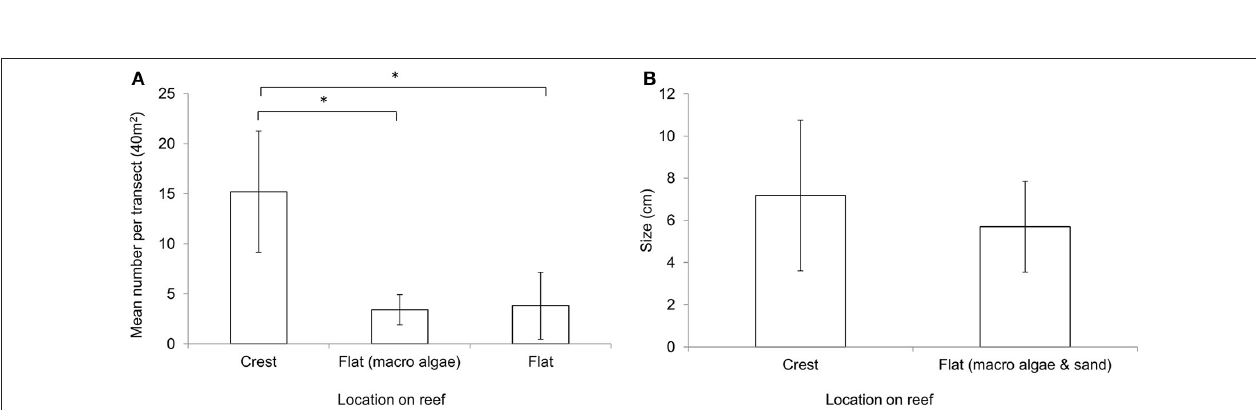
FIGURE 3 | Mean ( ± SD) photosynthetic efficiency (F V /F M ) for each of the four treatment groups over the 4 day period for (A) 0700, Low PAR and (B) 1100, high PAR. Flat and crest control groups: individuals measured without moving from respective locations on reef; handling group: individuals moved from reef crest to another location within reef crest; acclimatization group: individuals moved from reef crest to reef flat. Dashed vertical line represents time of translocation for handling and acclimatization groups.